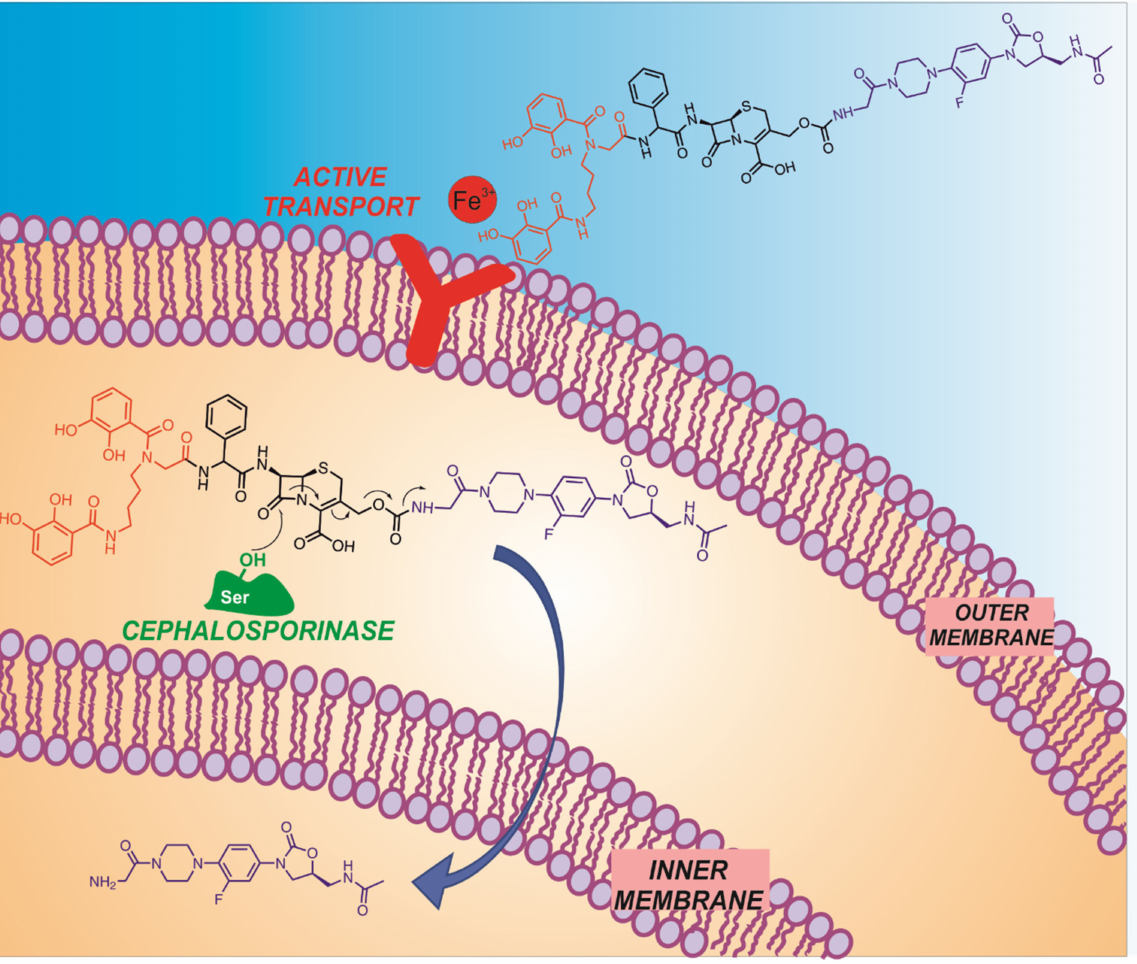
Figure 2. Sketched view of the cephalosporine-triggered release of oxazolidinone from the siderophore–cephalosporine– Eperezolid conjugate